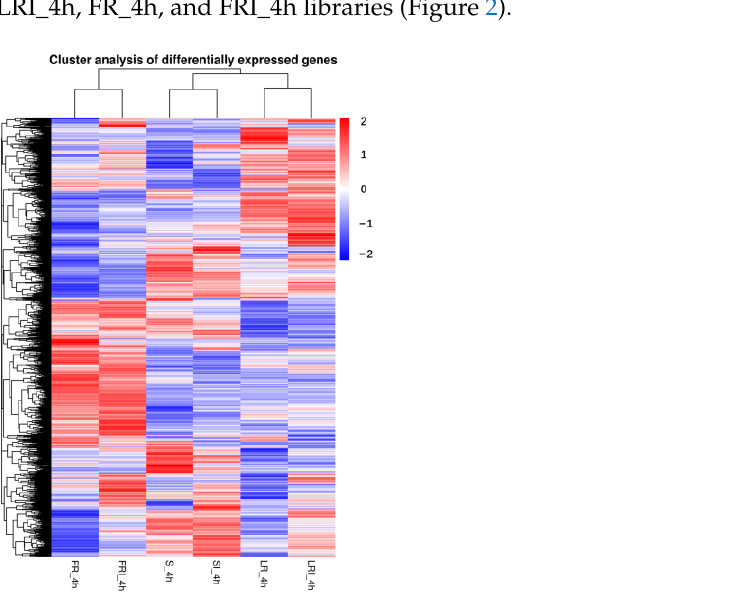
Figure 2. Hierarchical cluster analysis of the differentially expressed genes (DEGs) of a wild-type strain and two fludioxonil-resistant mutants 4 h after growing in PDB medium amended with fludioxonil. The blue to red colors represent gene expression levels (i.e., FPKM values from − 1 to 1). S, LR, and FR were gathered into three independent groups, each containing two clusters (i.e., with and without fludioxonil induction). Noticeably, fludioxonil induced more dramatic change in gene expression profiles between FRI-4h and SI-4h than between LRI -4h and SI-4h, suggesting the involvement of more DEGs in FR response to fludioxonil. The corrected p -value 0.05 and an absolute value of log 2 (fold change) ≥ 1 were set as the cutoff standard to identify DEGs between the different libraries, including SI_4h vs.